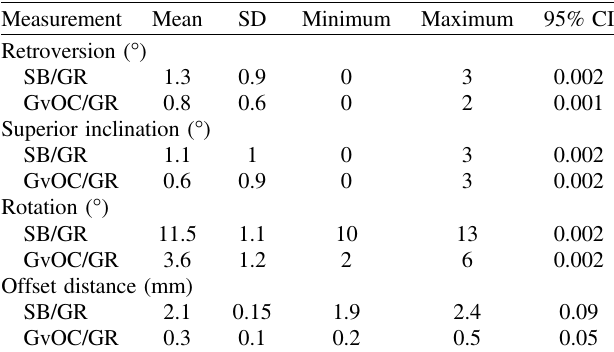
Table 3. Inter-observer reproducibility tests for SB/GR and GvOC/ GR planes position calculations in one